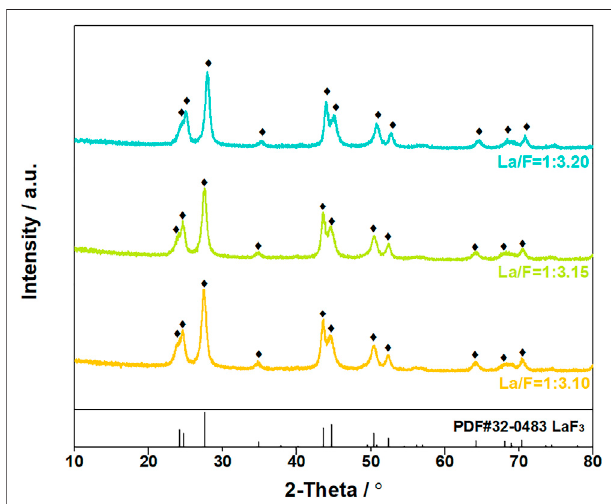
FIGURE 4 | XRD patterns of fi ltration residues obtained in solutions at La/F molar ratio of 1:3.10, 1:3.15 and 1:3.20 after reaction for 1 h.